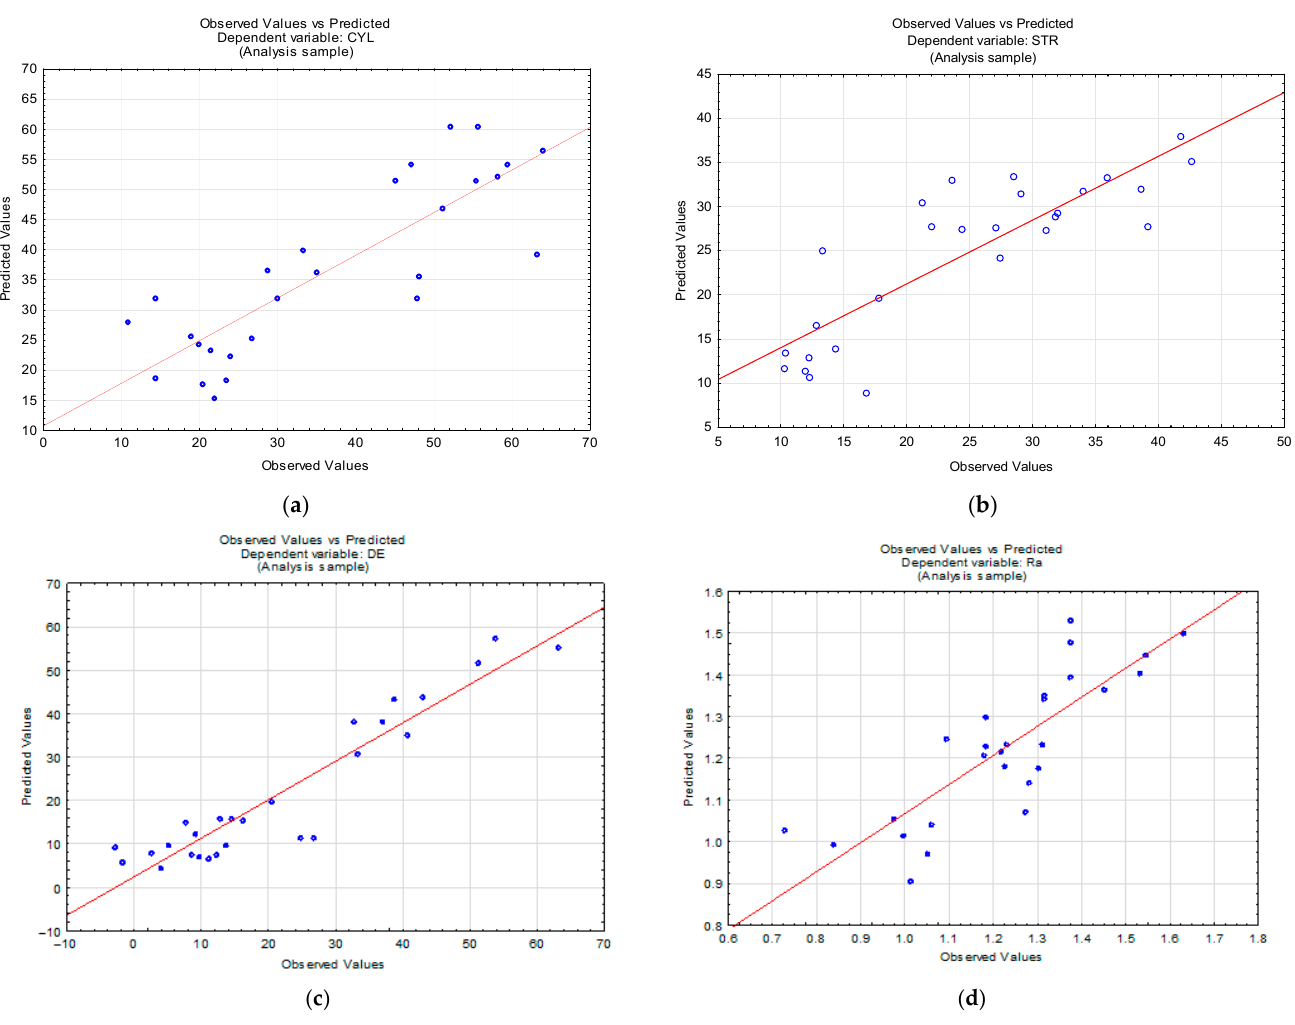
Figure 7. Experimental versus predicted data: ( a ) the cylindricity error; ( b ) the straightness error; ( c ) the diameter error; and ( d ) the parameter R a .